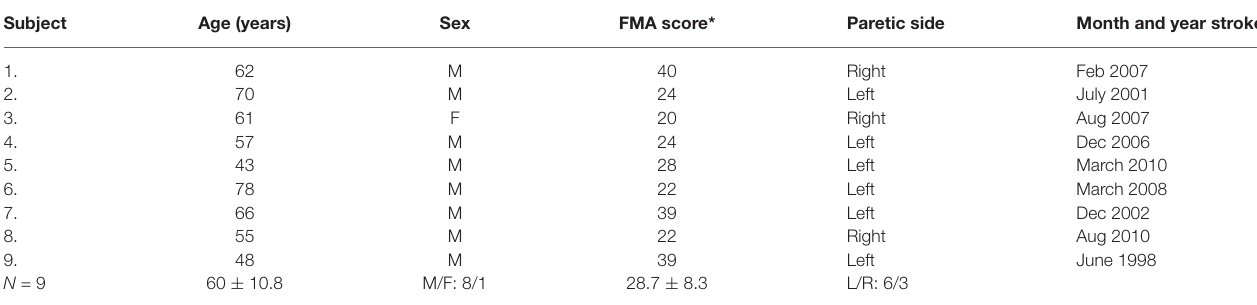
TABLE 1 | Characteristics of the analyzed subjects